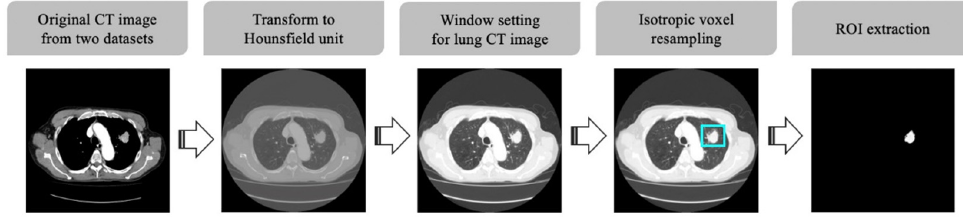
Figure 1. CT image preprocessing pipeline.